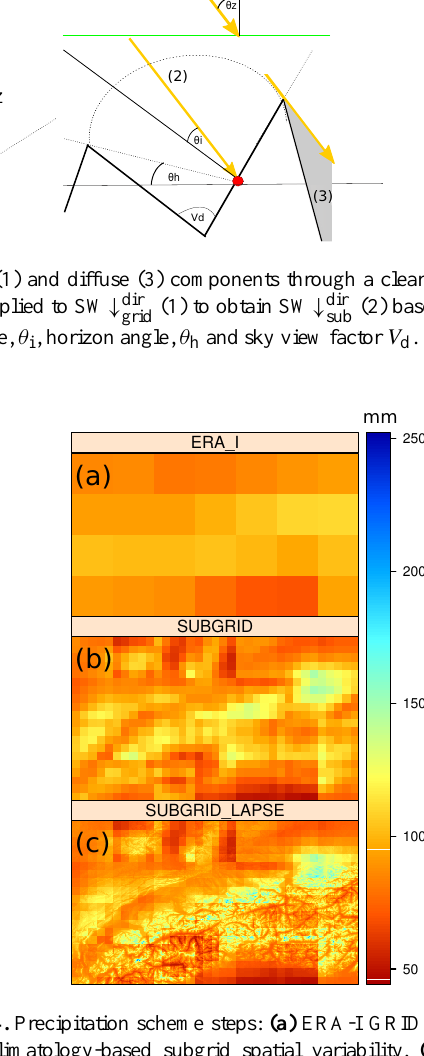
Fig. 4. Precipitation scheme steps: (a) ERA-I GRID precipitation, (b) climatology-based subgrid spatial variability, (c) lapse-rate- based vertical